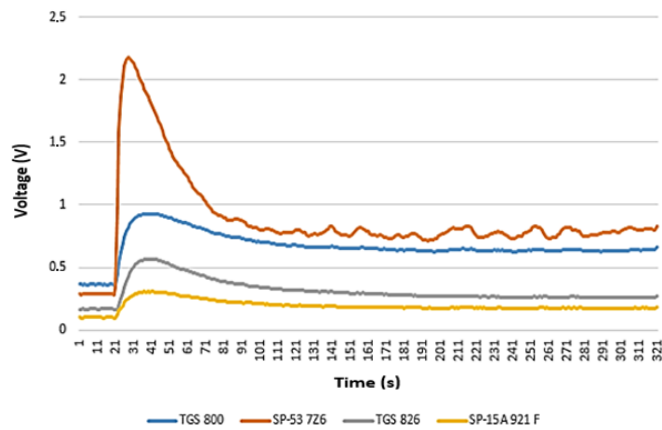
Figure 10. Response of the sensors without temperature modulation, subjected to a sample of 2%. (Moscatel